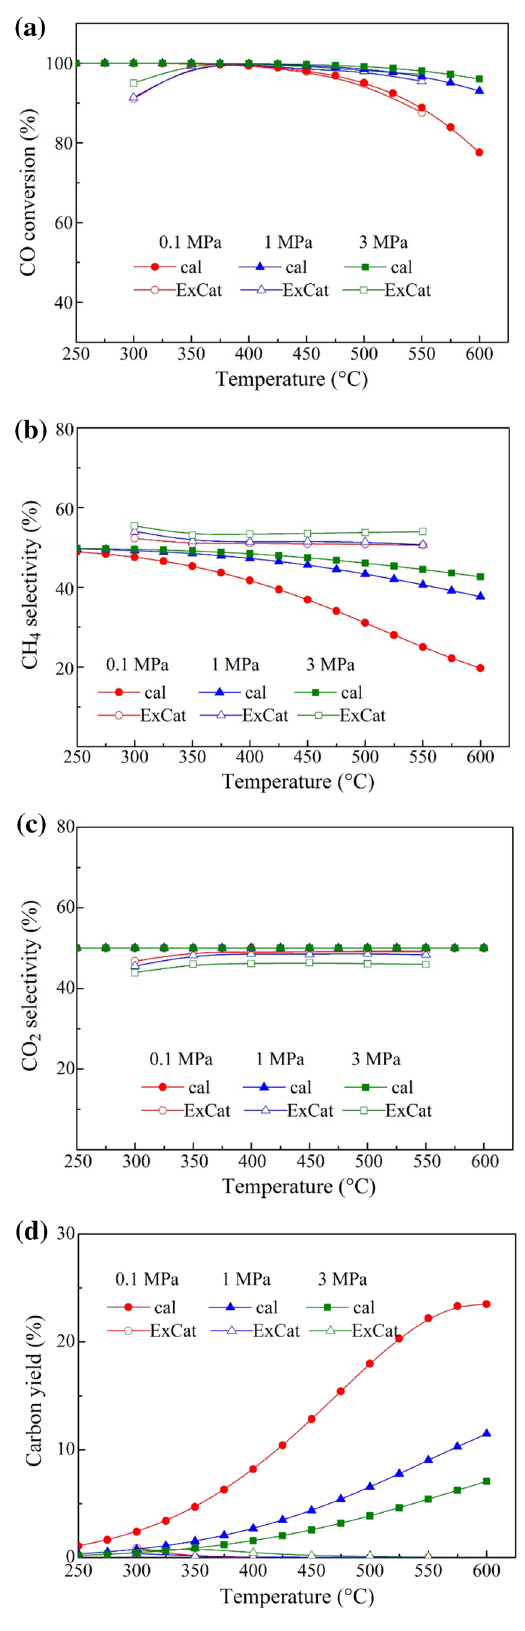
c Fig. 10 Comparison between experimental results and calculated